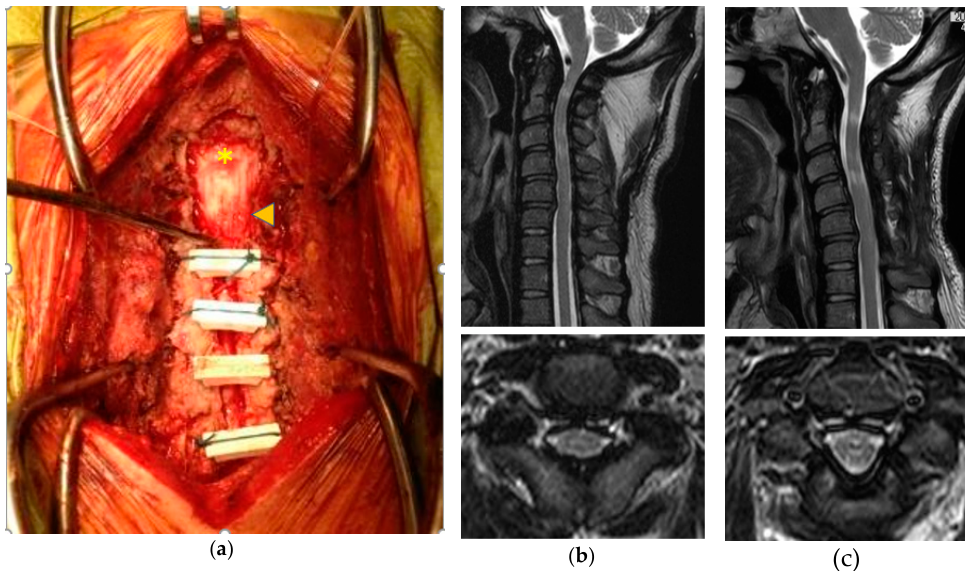
Figure 6. Cervical decompression surgery for MPS. Open-door laminoplasty from C3–C6 using hydroxyapatite spacers combined with C1 and C2 laminectomy (arrowhead) and suboccipital decompression (yellow asterisk) was performed in a 37-year-old man with MPS II ( a ). Cervical stenosis before surgery ( b ) was totally decompressed postoperatively ( c ). Numbness and clumsiness in both hands improved, although high signal intensity was still present after surgery. (The upper images are sagittal and the lower ones are axial T2-weighed magnetic resonance images in ( b ) and ( c )) .